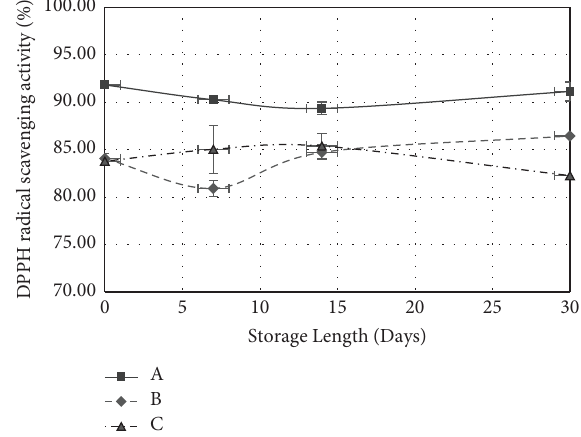
Figure 4: Te antioxidant stability of moringa leaves extract powders during 30 days of